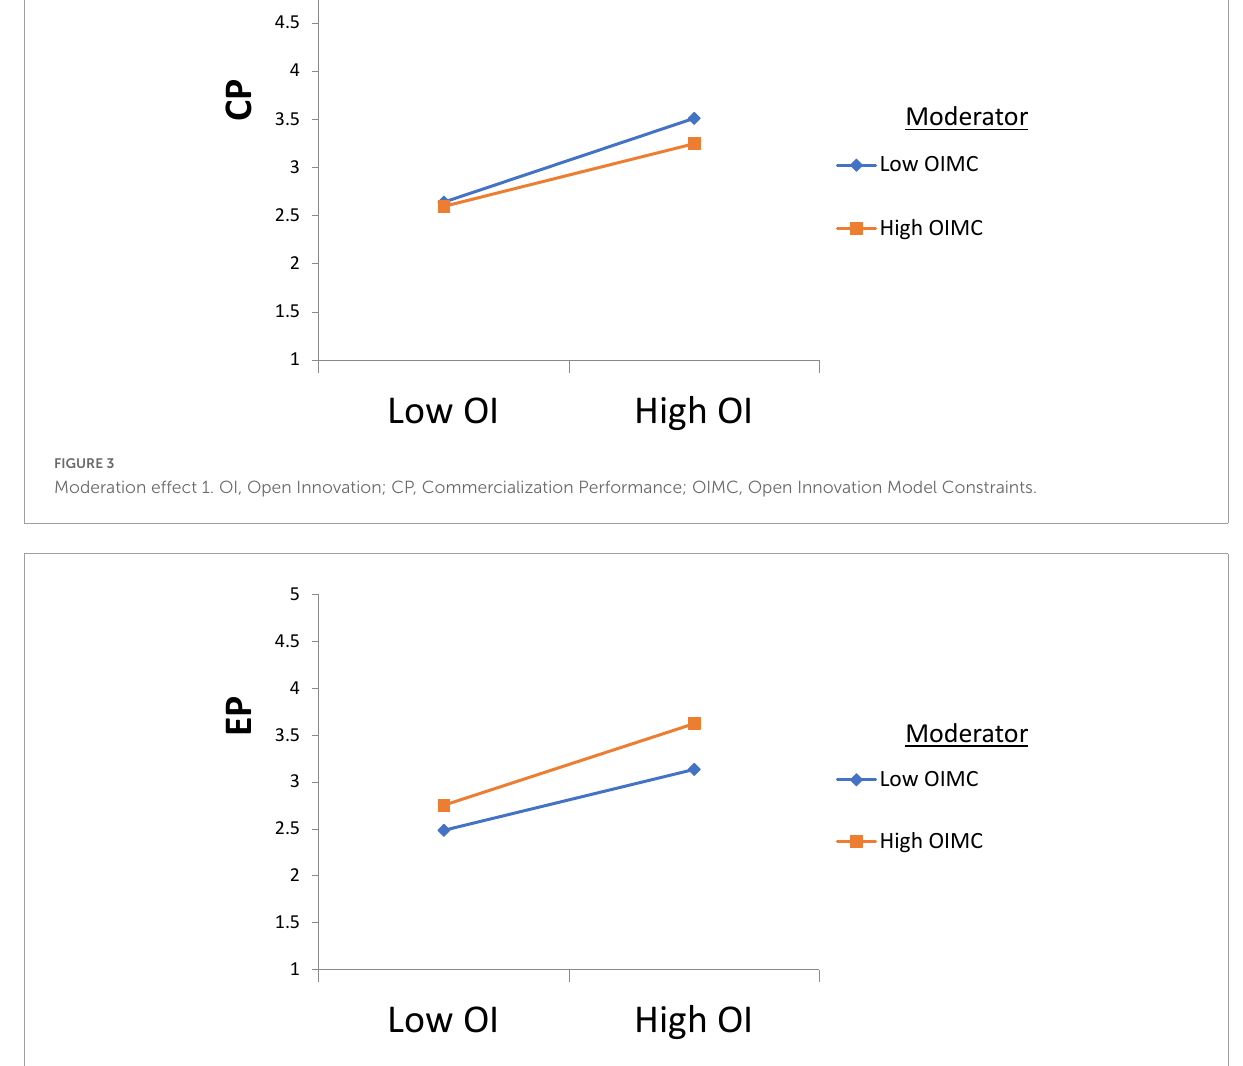
FIGURE4 Moderation effect 2. OI, Open Innovation; EP, Entrepreneurial Performance; OIMC, Open Innovation Model